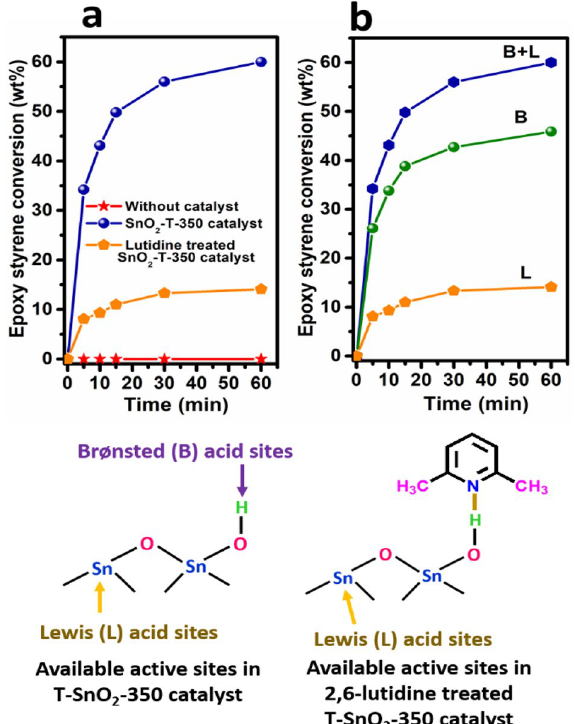
Figure 4. ( a ) Catalytic performance of 2,6-lutidine treated and untreated T-SnO 2 -350 catalysts for alcoholysis of epoxy styrene with methanol. ( b ) Contribution of nature of corresponding active sites responsible for alcoholysis reaction. Reaction conditions: epoxy styrene = 2 g, methanol = 5.3 g (mole ratio = 1:10), catalyst = 0.1 g, reaction temp = 65